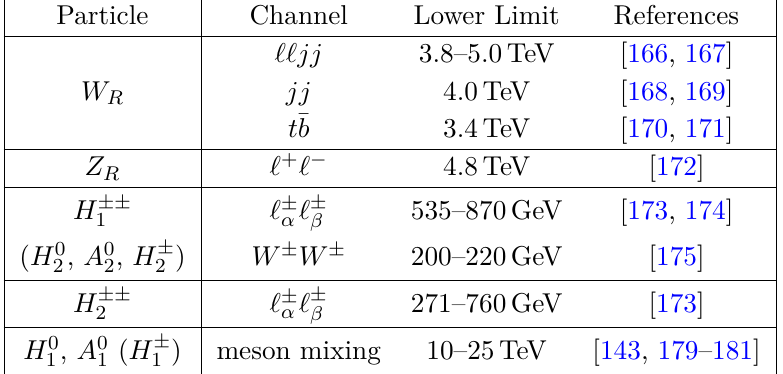
Table 1 . Current most stringent experimental limits on the masses of W R , Z R , H ±± , A 0 in the LRSM. The particles in parentheses are mass degenerate with them, if there is any. H 0 1 1 See text for more details.